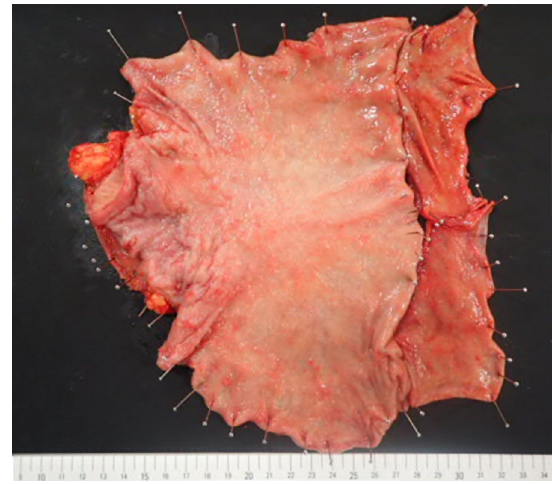
Fig. 4 Surgical specimen revealed a type 3 gastric tumor centered in the antrum and pylorus measuring 180 mm